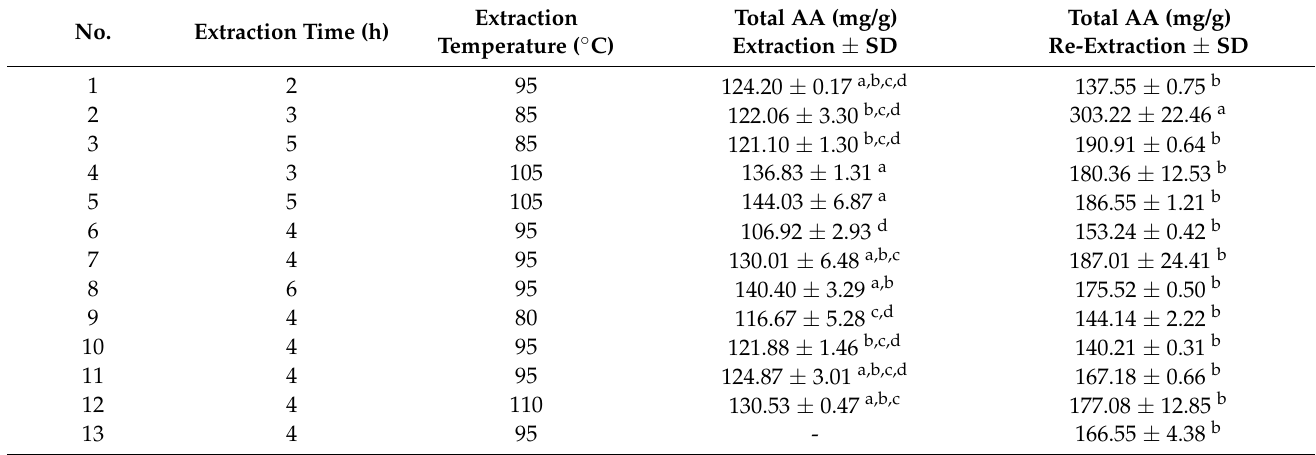
Table 8. Total essential amino acid profile for the conventional extraction and